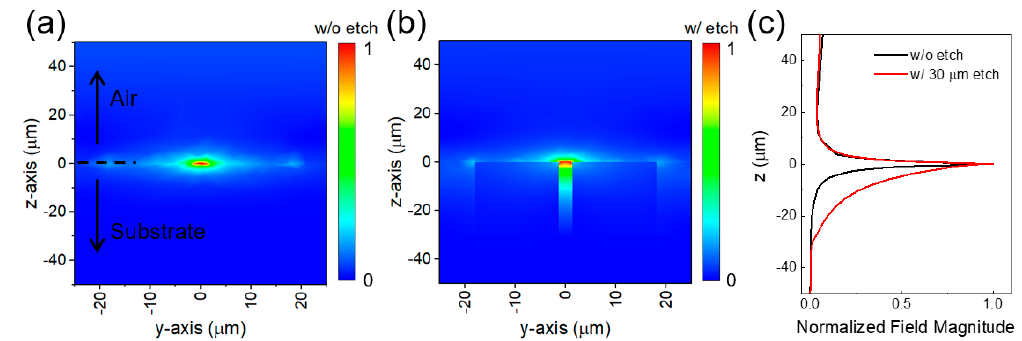
Figure 2. Field distribution near the metasurface at x = 0 for ( a ) without and ( b ) with an etch depth of 30 µ m. ( c ) The electric field line profile along the z axis at x = 0 and y = 0 without (black line), and with (red line) an etch depth of 30 µ m.